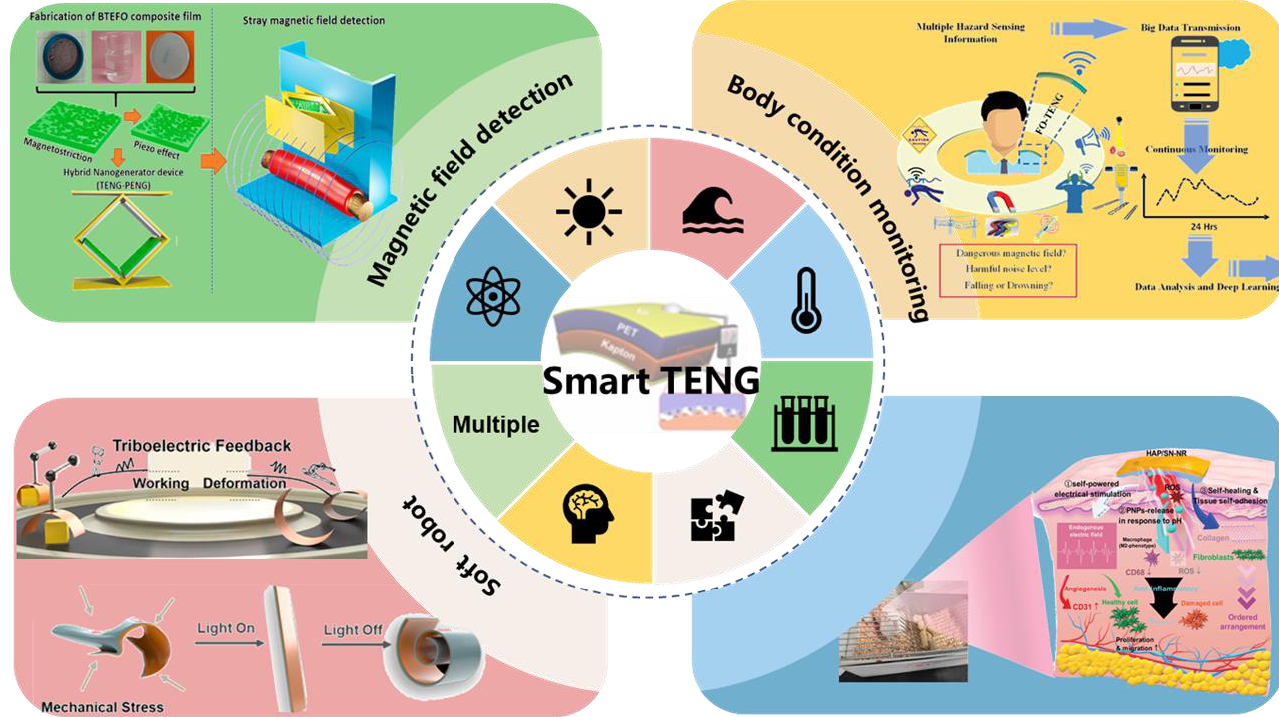
Figure 1. Diverse applications of TENGs that are based on multiple stimuli-responsive materials.